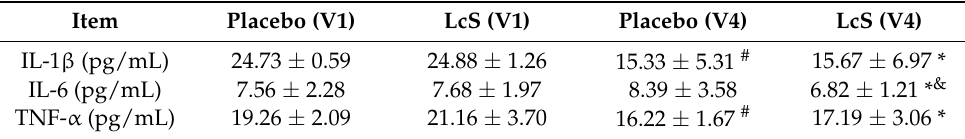
Table 4. The effects of LcS on the proinflammatory